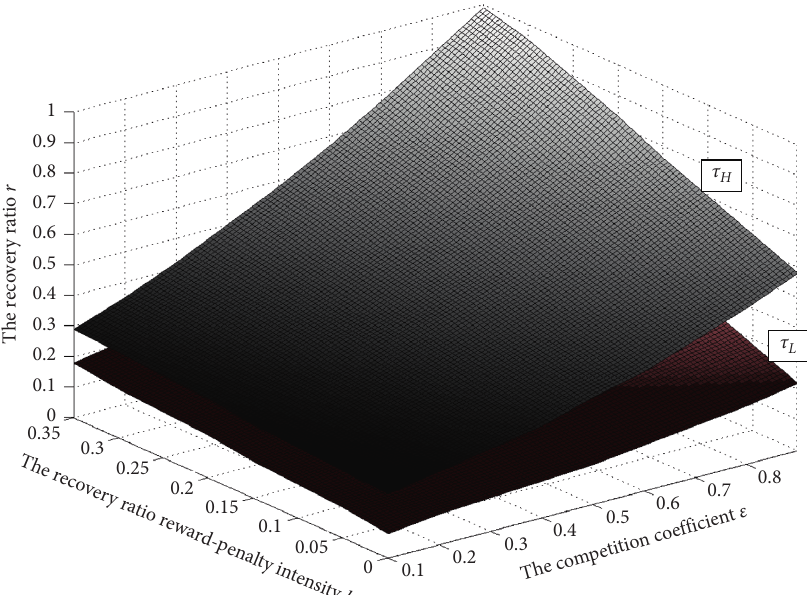
Figure 9: WEEE recovery rate τ